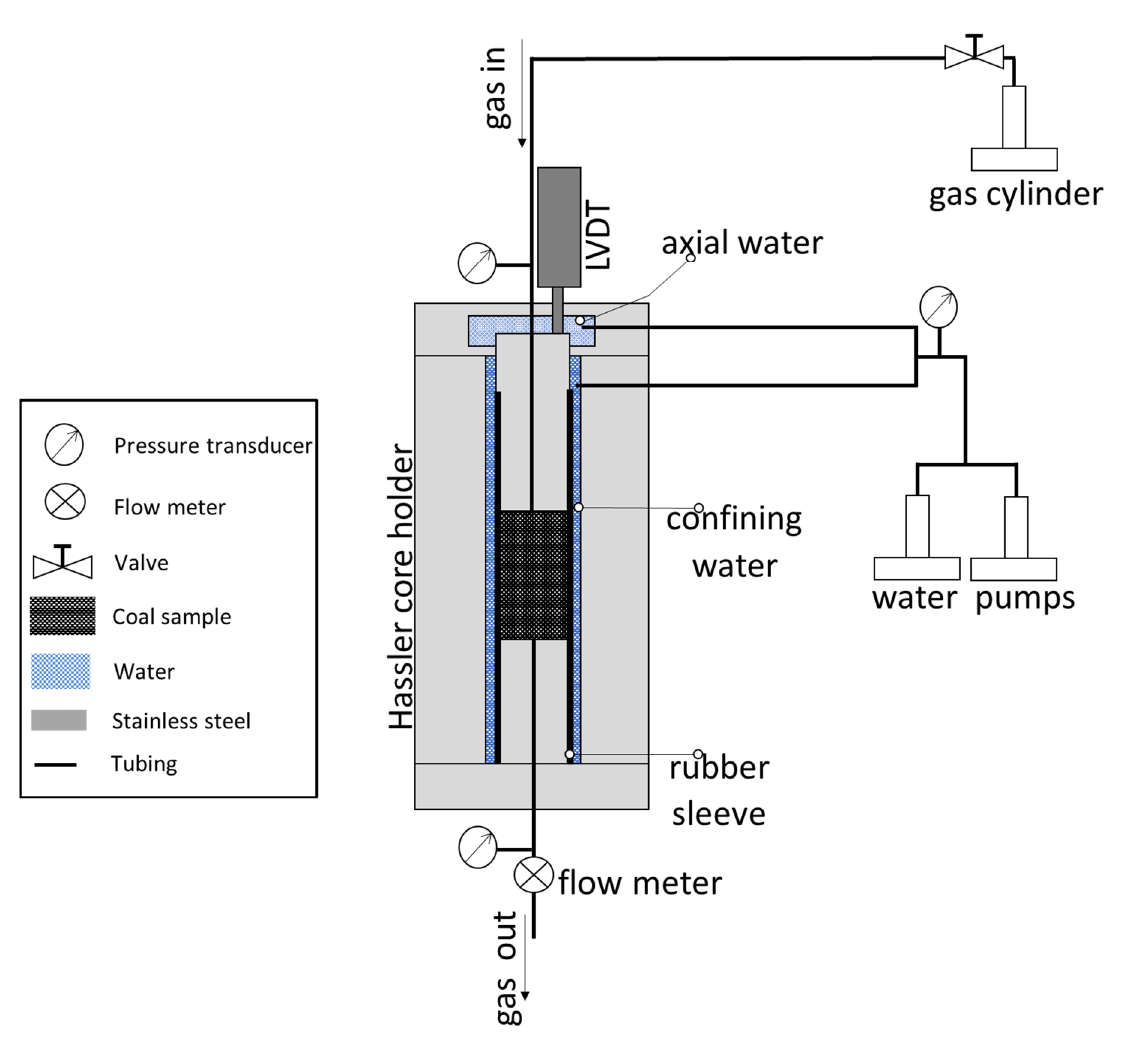
Figure 1. Experimental setup (not to